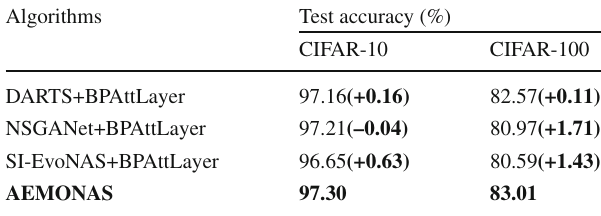
Table 4 The classification accuracy(%) of DARTS+BPAttLayer, NSGANet+BPAttLayer, SI-EvoNAS+BPAttLayer,